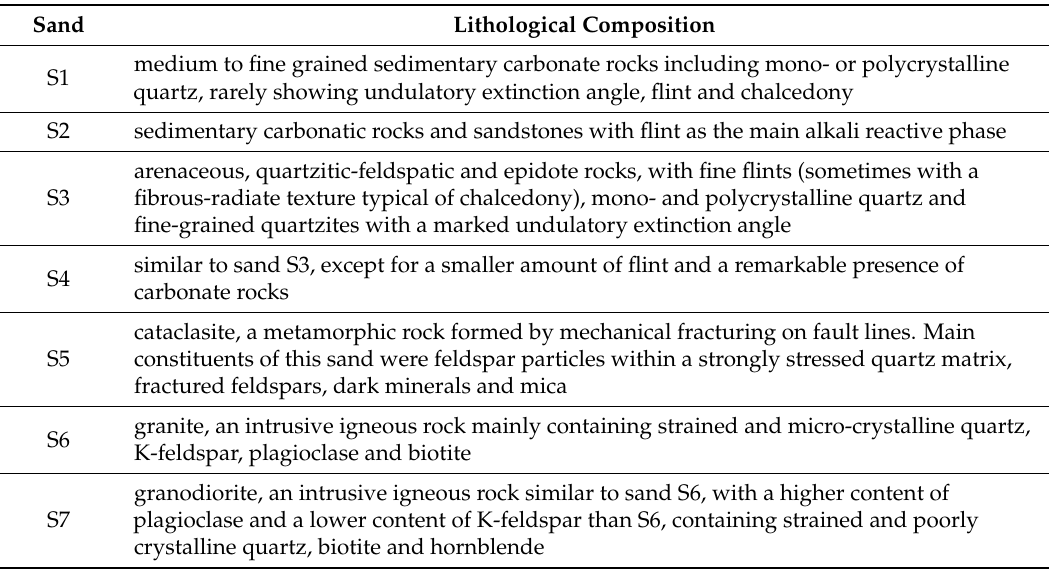
Table 1. Lithological compositions of sands